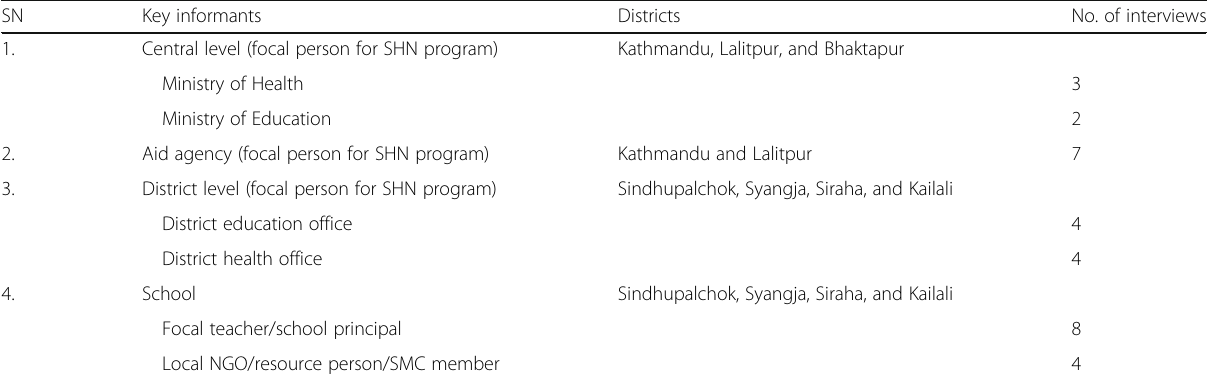
Table 1 Districts, key informants, and number of interviews SN Key